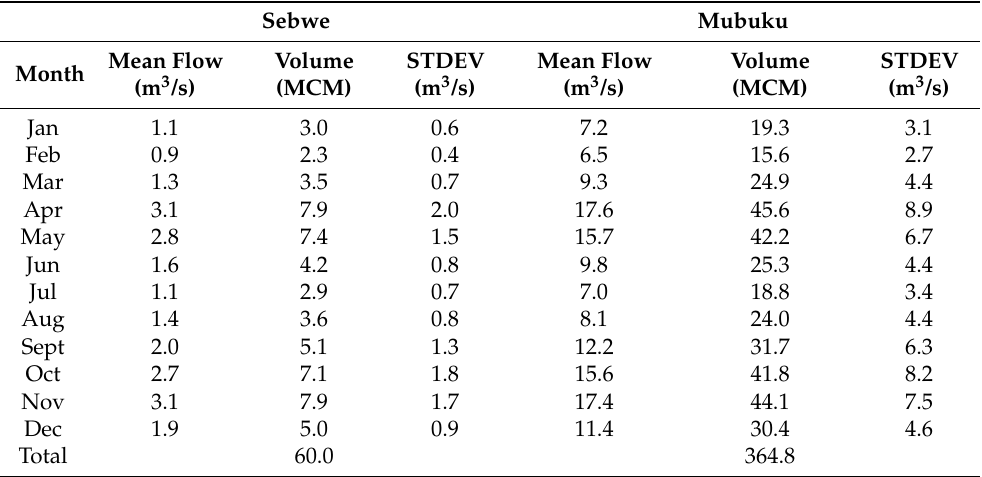
Table 4. Average monthly flow for Sebwe and Mubuku in 2015.